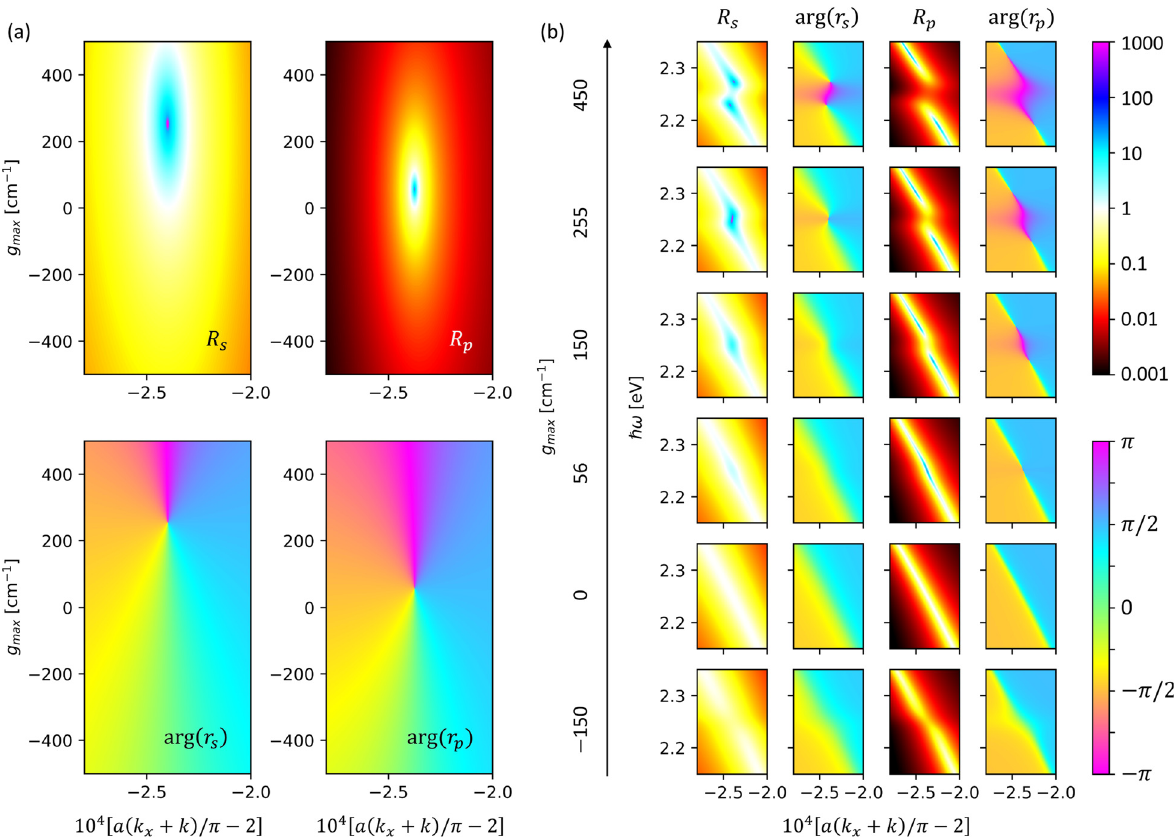
Figure 5: Reflection from a metasurface with either gain or loss. (a)Dependenceofthereflectivity R s , p andthere fl ectedphasearg ( r s , p ) onthein-planemomentum k x (horizontalaxis)andonthegaincoef fi cient g max (vertical axis) at a fi xed photon energy 2.25 eV. Negative g max means an effective loss. (b) Frequency – momentum distributions of R s , p and arg ( r s , p ) at various g max , showing the birth of singularities at ∼ 255 cm − 1 for the s-polarized light and ∼ 56 cm − 1 for the p-polarized